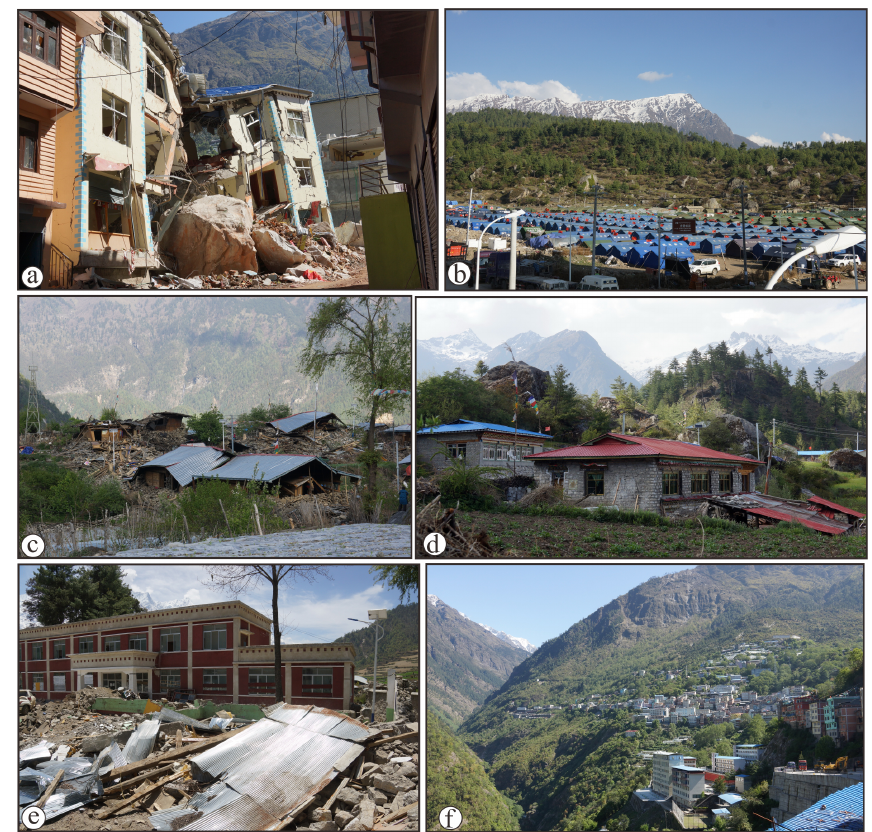
Figure 4. Typical earthquake damage in southern Tibet and comparison of houses of different construction (locations shown in Fig. 5). (a) Huge rockfall that smashed the resident committee office building at Disigang Village, about 0.7km south of Zhangmu, where seven persons were killed (intensity IX) (site 1, Fig. 5a). (b) A temporary settlement for earthquake survivors at Jilong. (c) Destroyed houses of stone block masonry or adobe construction in Jifu Village southwest of Jilong (intensity VIII) (site 8, Fig. 5b). (d) Houses of cement-bonded stone or brick construction in Jifu Village (intensity IX). (e) Destroyed old houses and new buildings that are still standing at Sale Town Primary School (intensity VIII) (site 7, Fig. 5b). (f) Few collapsed houses at Zhangmu due to the brick structure or reinforced concrete construction (intensity